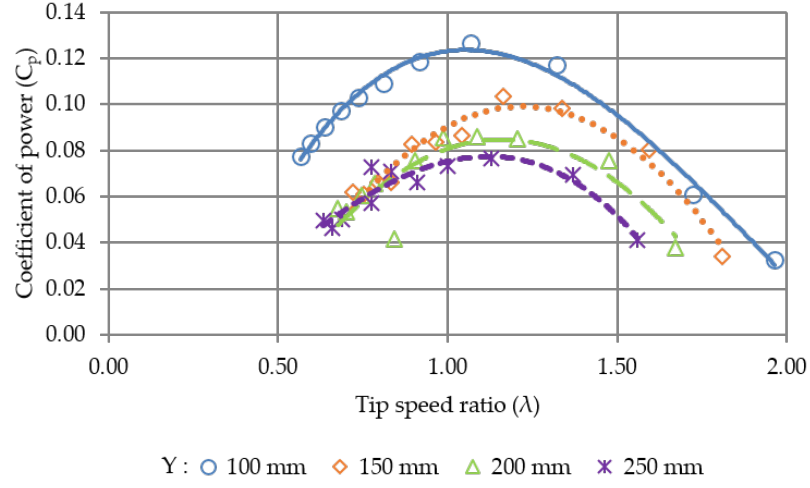
Figure 14. Coefficient of power of CAWT at various heights above the rooftop. Table 4. Summary of experimental results on variation of height.